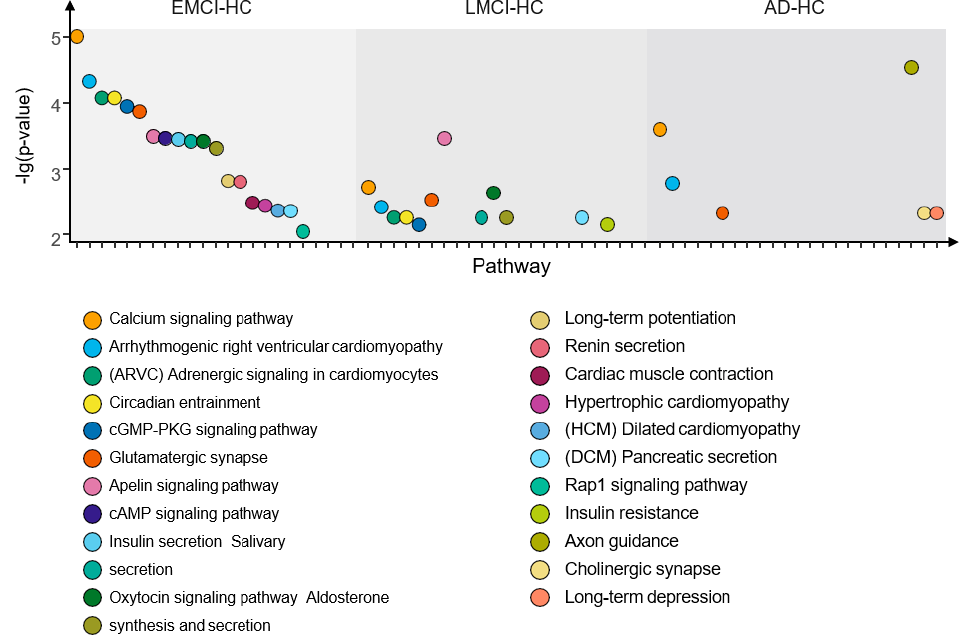
Figure 13. The pathways with corrected p -value < 0.01 of the EMCI − HC group, LMCI − HC group and AD − HC group.